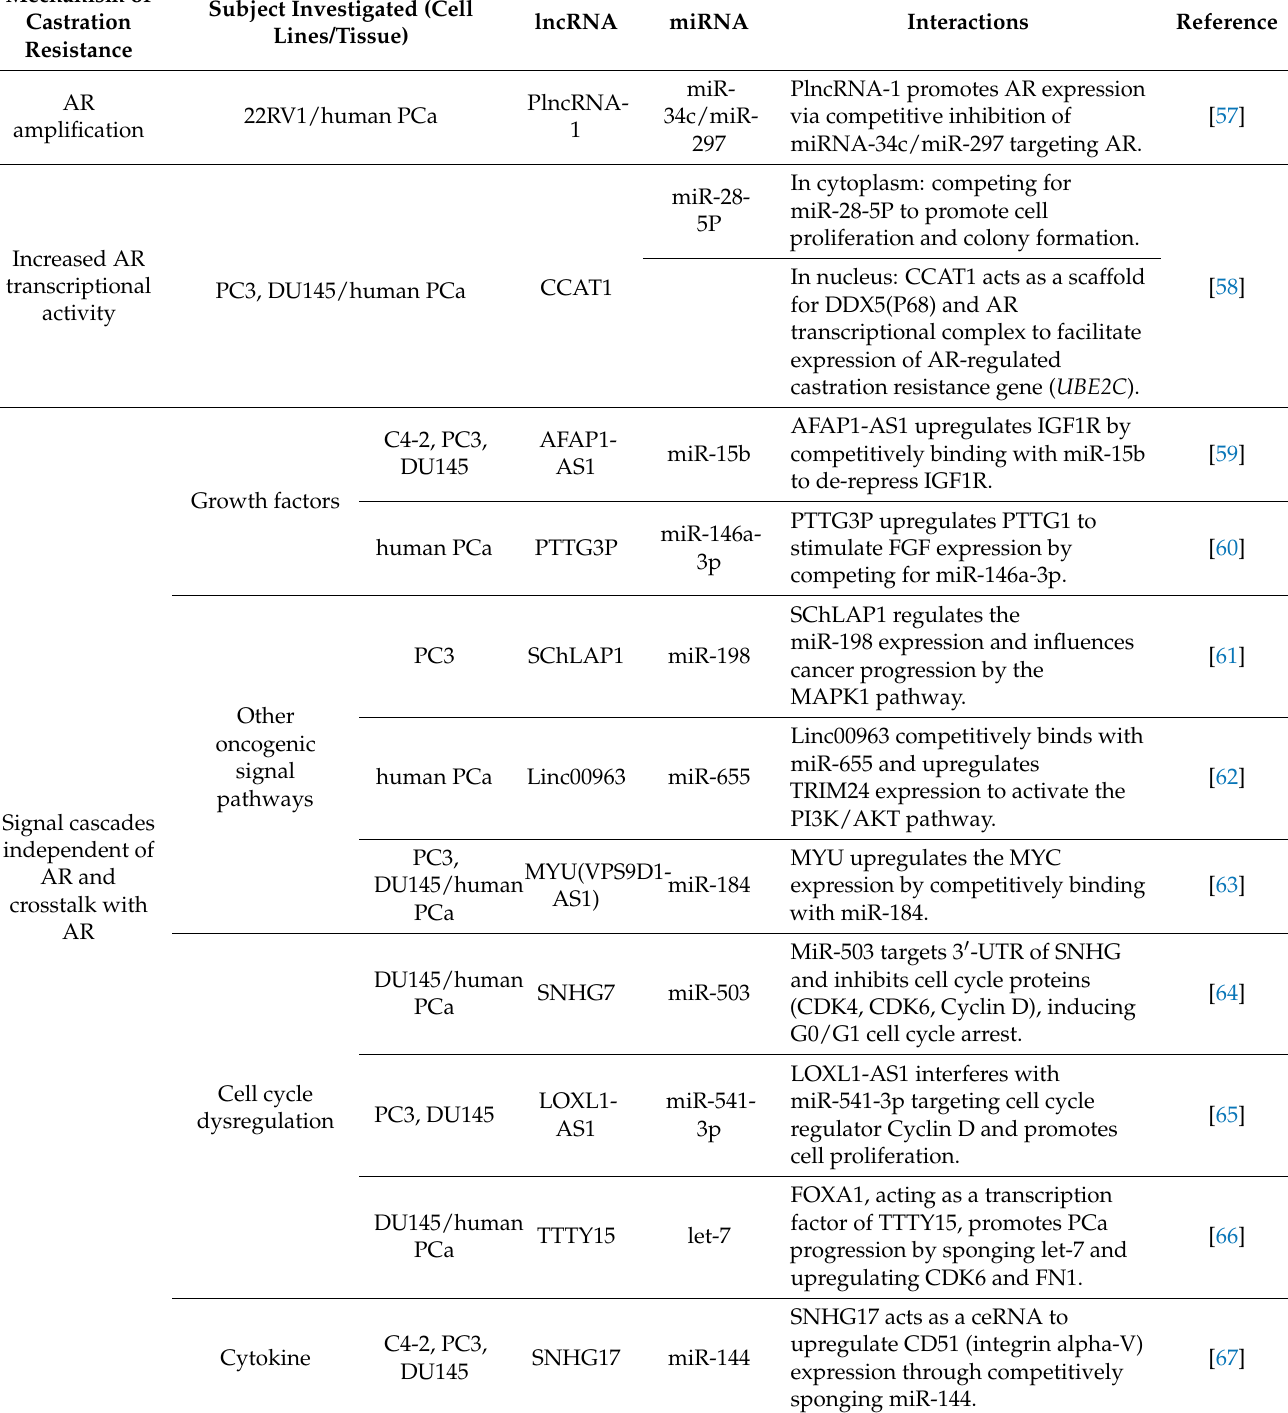
Table 1. Content curation of long-non-coding RNA (lncRNA) and its targeting microRNA (miRNA) and related mechanism of castration resistance prostate